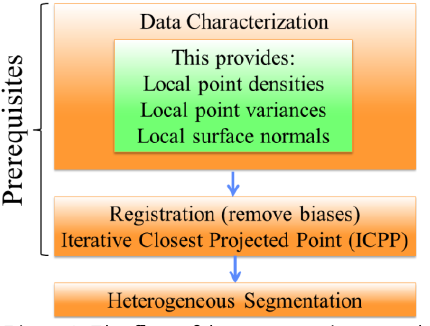
Figure 1: The flow of the segmentation procedure